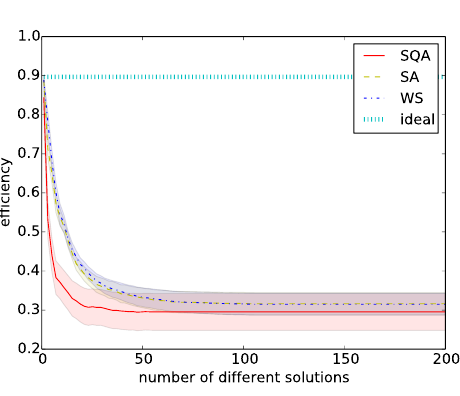
Figure 16: Average efficiency of a 5-SAT filter with a clauses-to-variables-ratio of α χ The solutions used to construct the filter were chosen randomly from the found solutions.